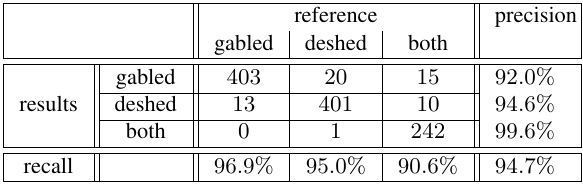
Table 4. multi-class classification results of dormer types using a 10-fold cross validation. Point density: 11 points/m 2 .